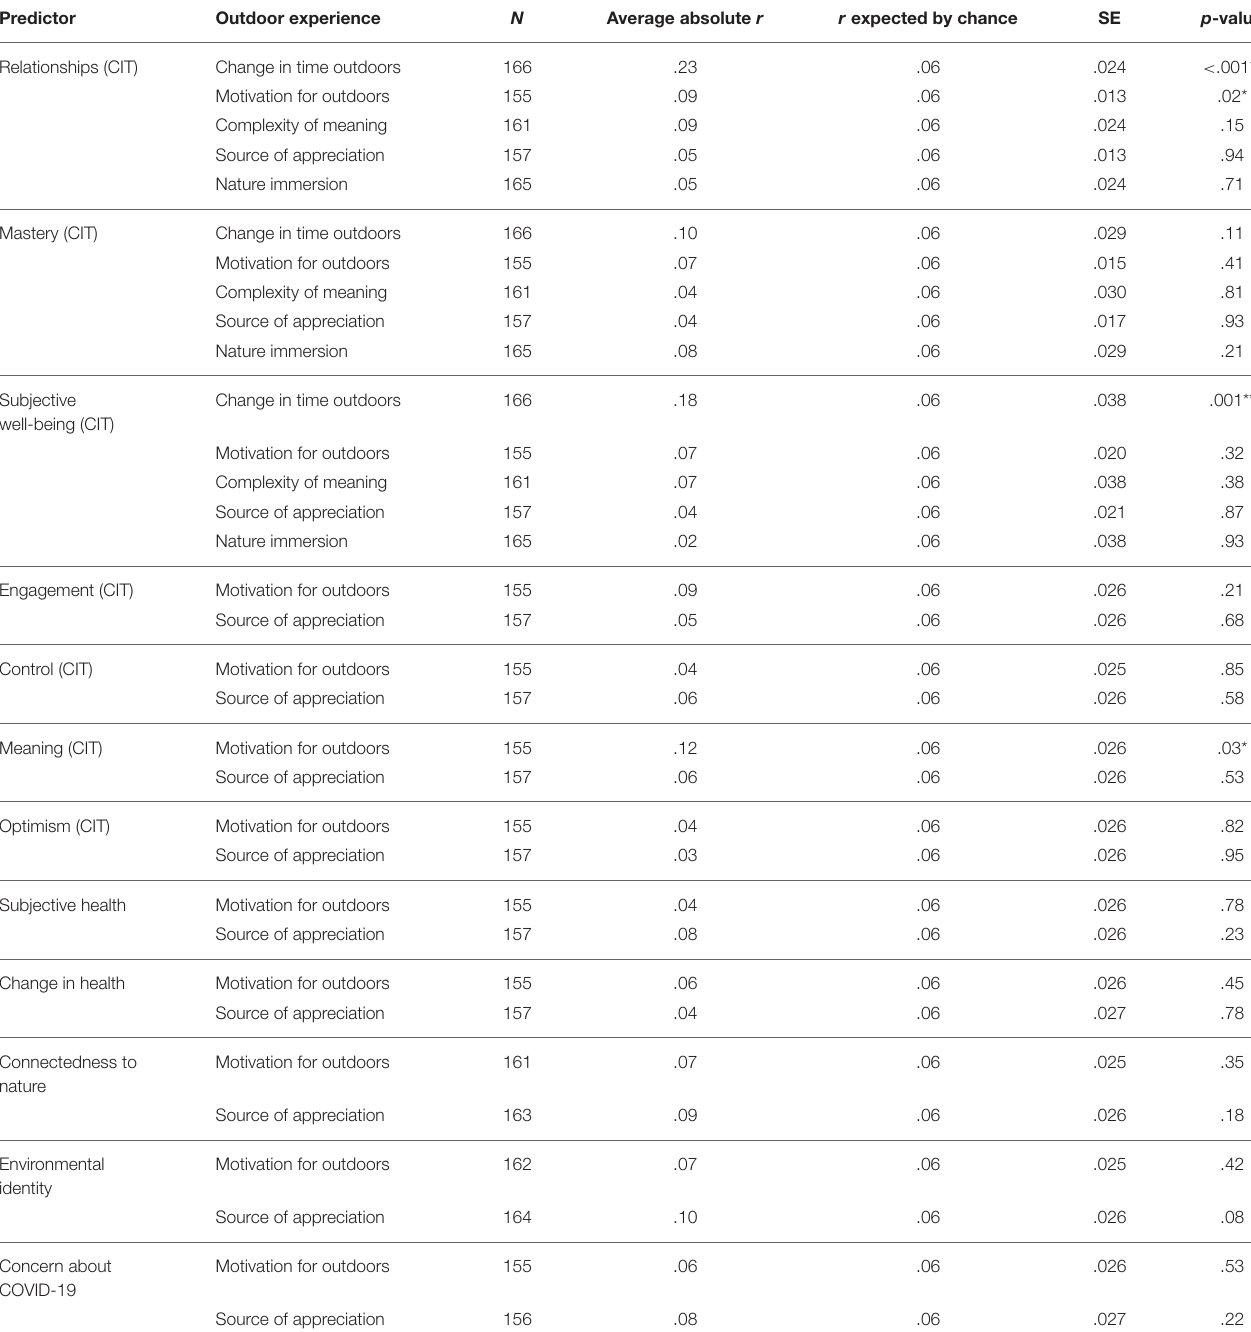
TABLE 4 | Randomization test results for correlations of outdoor experiences with comprehensive inventory of thriving.